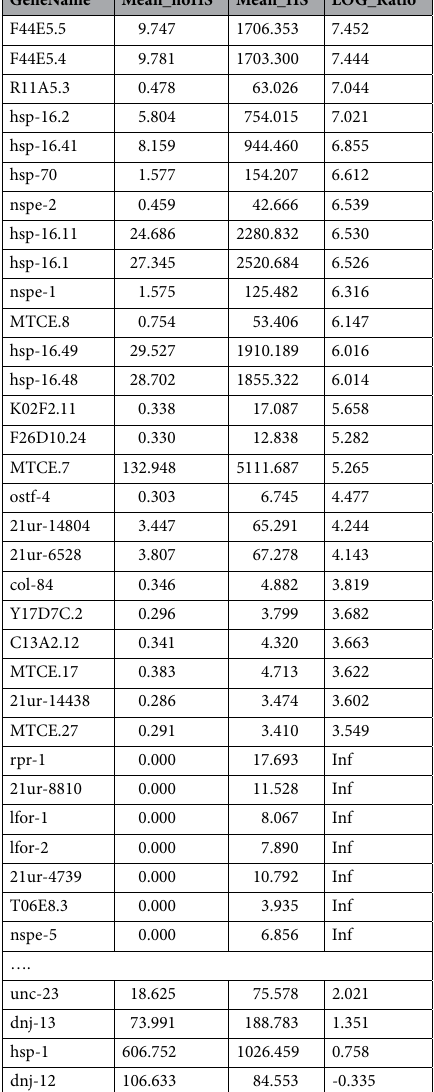
Table 3. Significantly enriched genes in the heat-shock experiments of Brunquell et al . 15 . Individual induced genes are shown compared to their non-stressed state. To define, which genes are expressed, it is to be considered that the median count is 7.7 and 5.2 for the two conditions